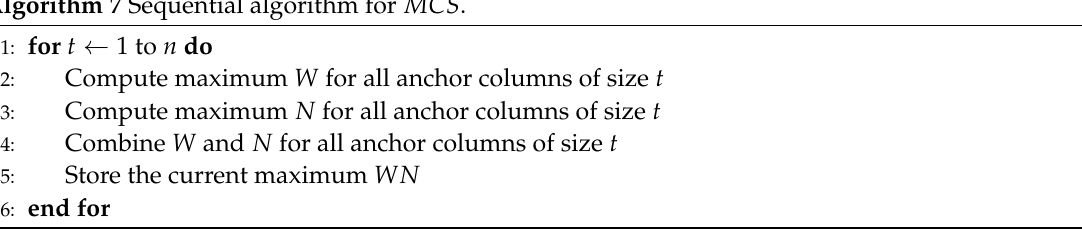
Algorithm 7 Sequential algorithm for MCS